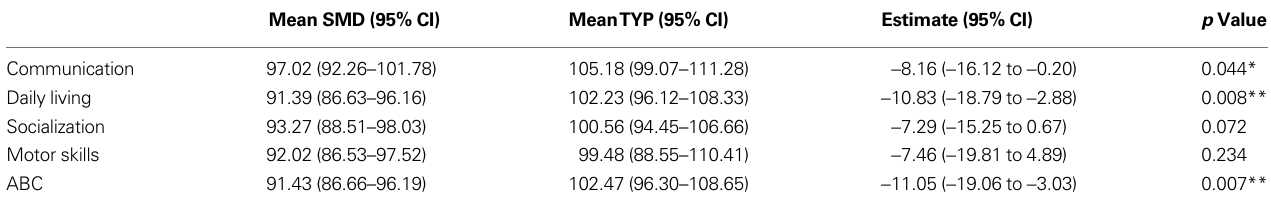
Table 6 | Vineland Standard Score differences between SMD and typical.